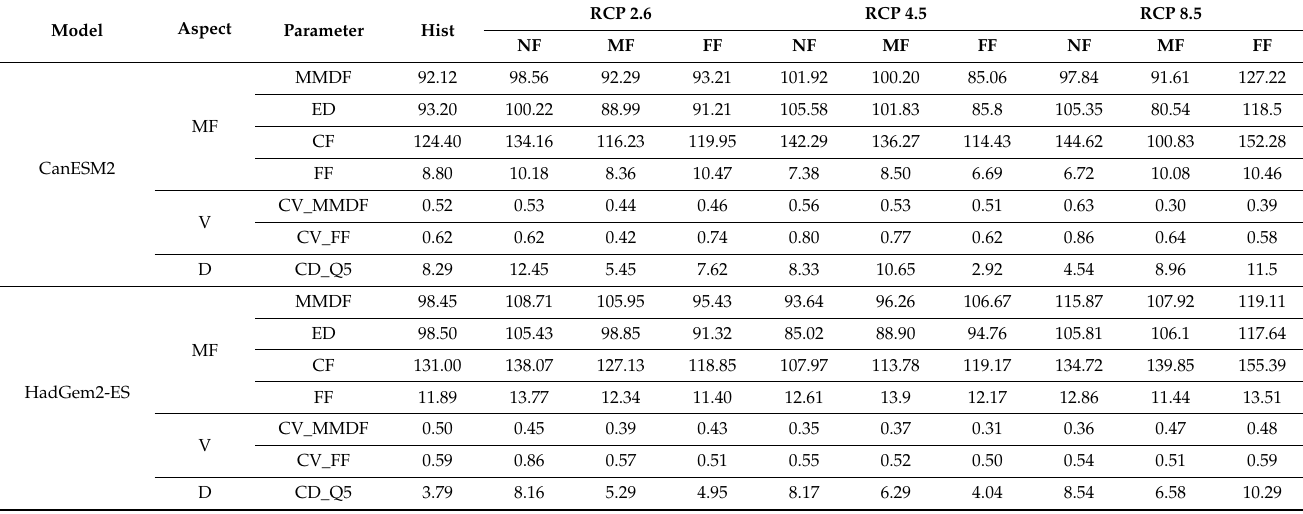
Table 6. Indicators of Hydrologic Alteration in Rivers (IAHRIS) results for floods in RCP 2.6, 4.5 and RCP 8.5 scenarios. Aspect: MF = Magnitude and frequency; V = Variability; D = Duration; Hist = historical data. Model Aspect